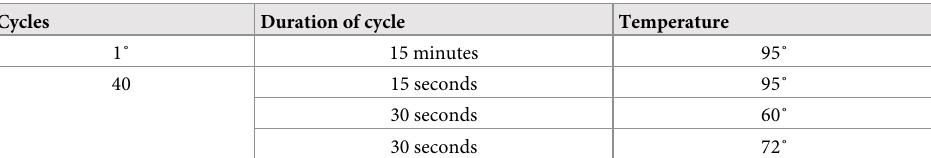
Table 2. The PCR program. Cycles